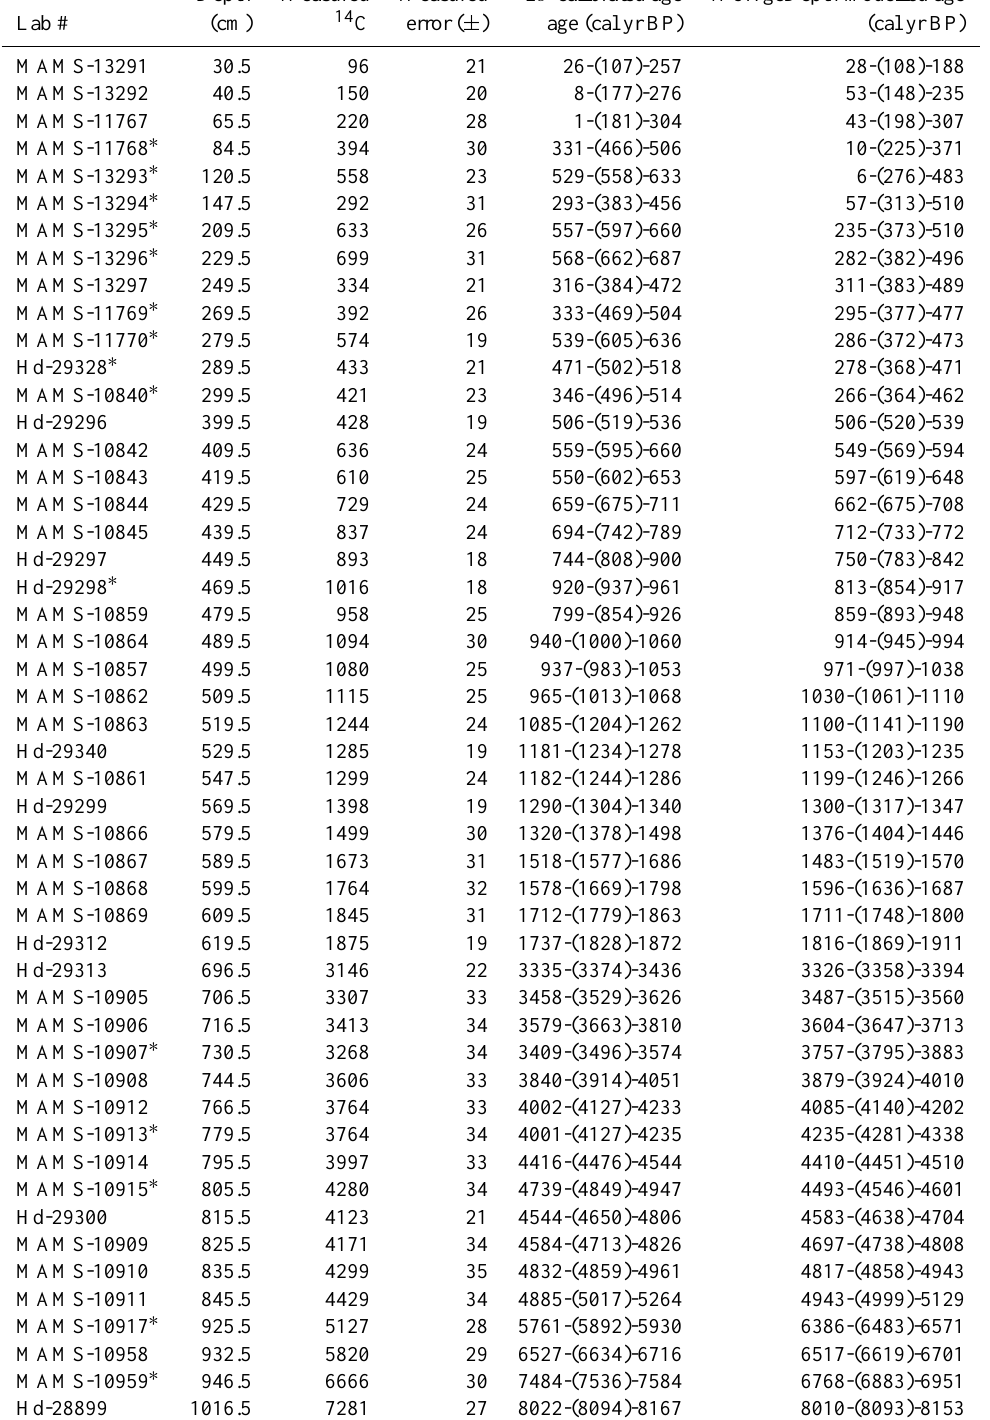
Table 1. Radiocarbon ages of core Pe852. The calibrated age ranges were calculated using CALIB 6.0.1 and the IntCal09 data set (Reimer et al., 2009). The modelled ages are the result of a probabilistic age–depth model using MCAgeDepth (Higuera, 2008). The range represents the 2 σ values, and the median ages are in